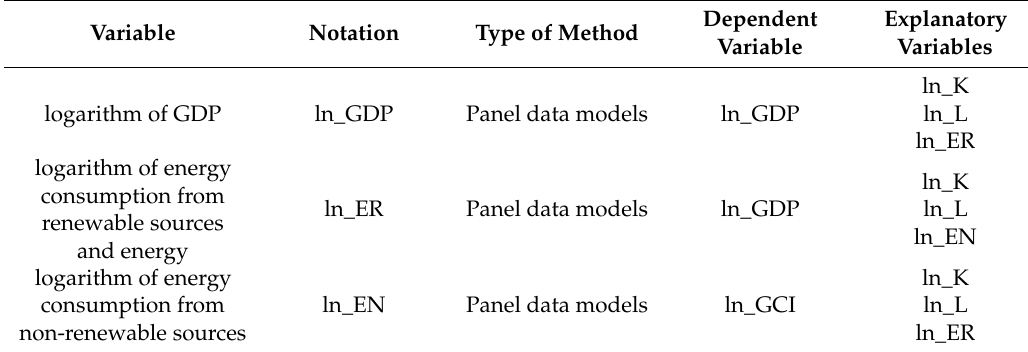
Table 1. Variables and methods used in this